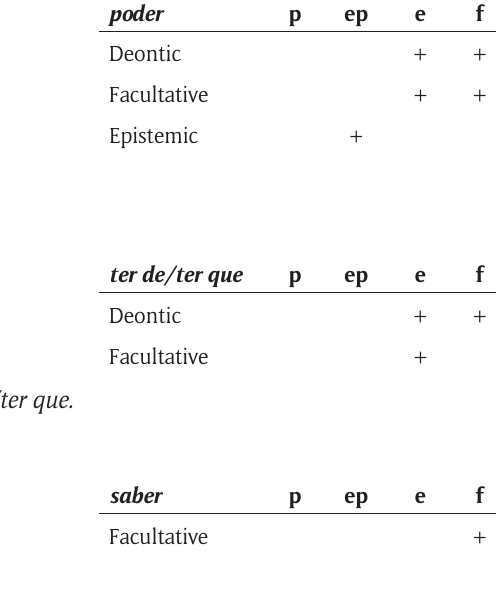
Table 7: Uses of saber .